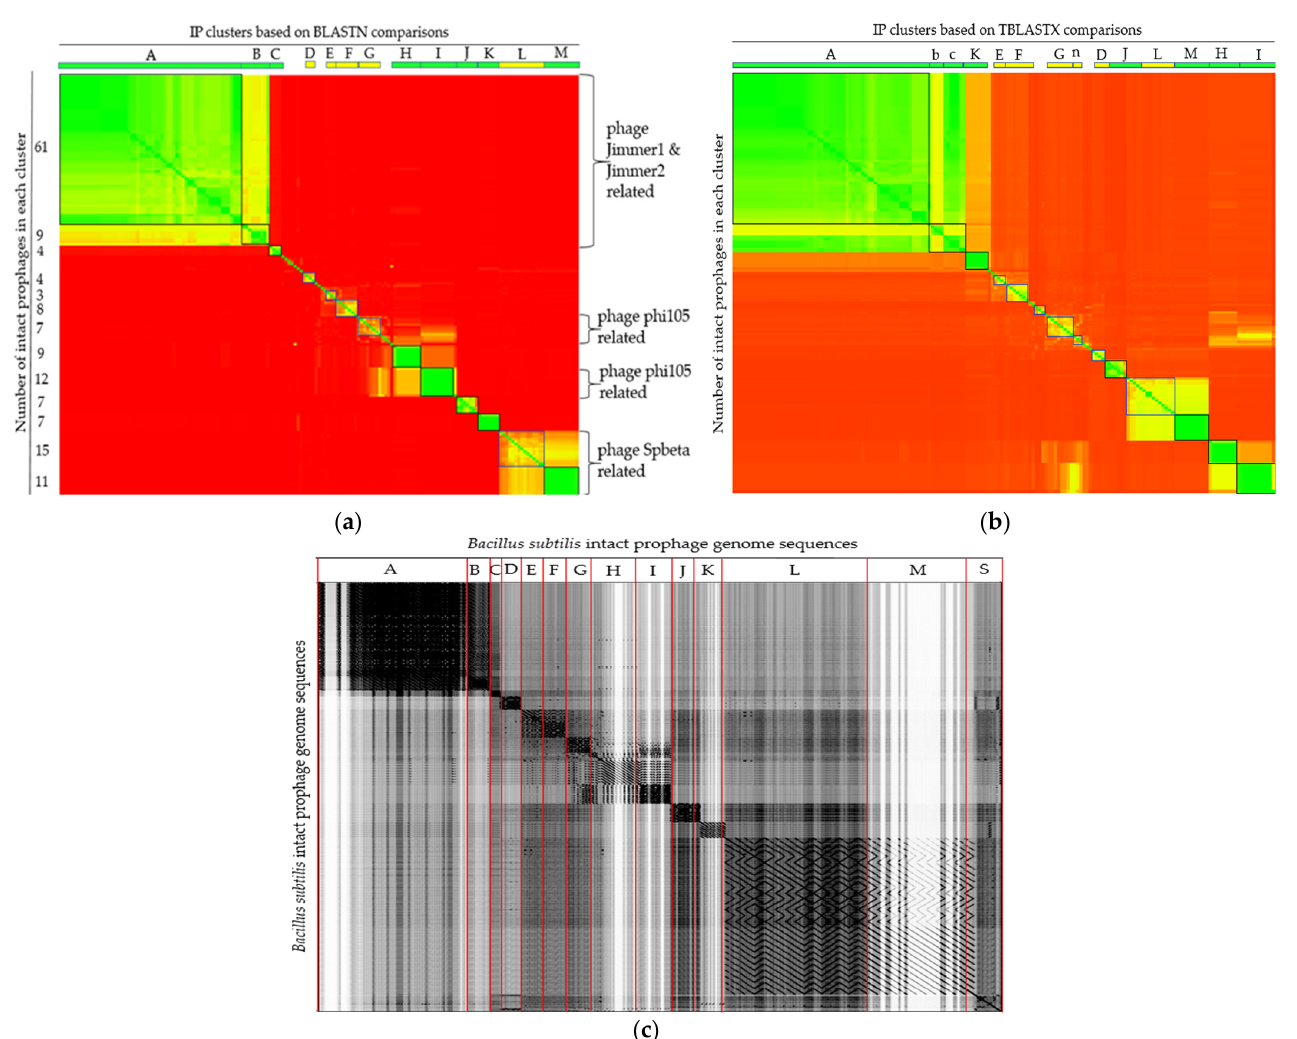
Figure 4. Comparison of 172 IP genome sequences predicted in B. subtilis ( a ) and ( b ) Gegenees heatplot generated using BLASTN and TBLASTX, respectively, with 200/100 settings. Heatplot colors indicate similarity ranging from nearly identical (green) to similar (yellow) or dissimilar (red). The corresponding numbers of group members of each cluster are indicated on the y -axis. Labeled boxes at the top represent IP clusters. ( c ) Dotplot alignment of IP sequences generated by Gepard.